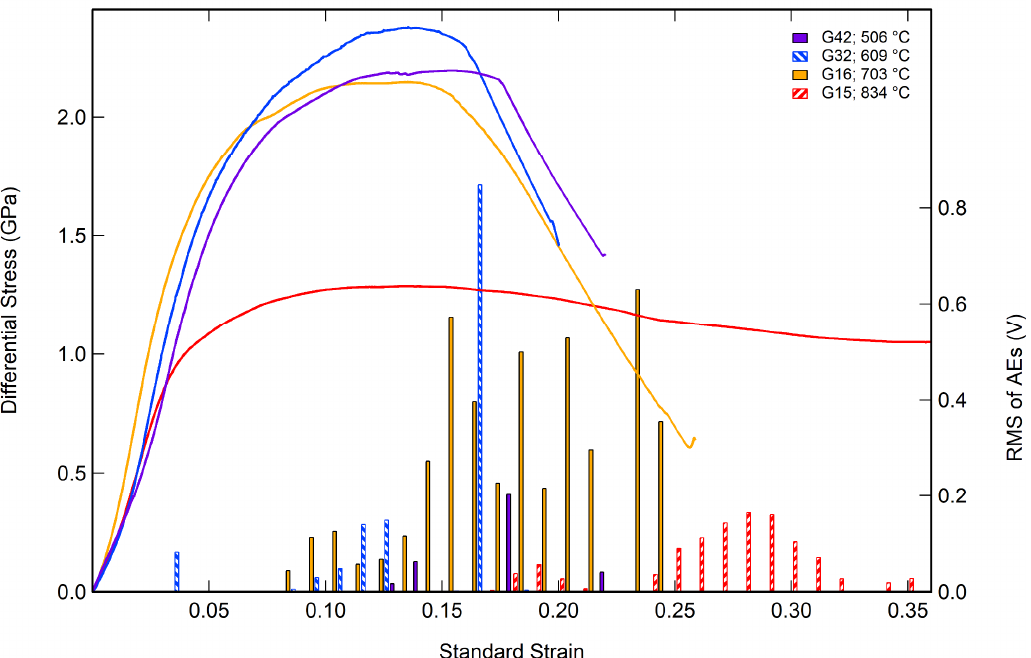
Figure 5. Effect of temperature on acoustic energy productivity. Lines show the stress-strain curves of some of the experiments presented in Figure 4. To evidence the effects of temperature, one curve for each temperature investigated is presented. Bars represent the cumulative RMS of AEs for each 1% increment of sample strain.